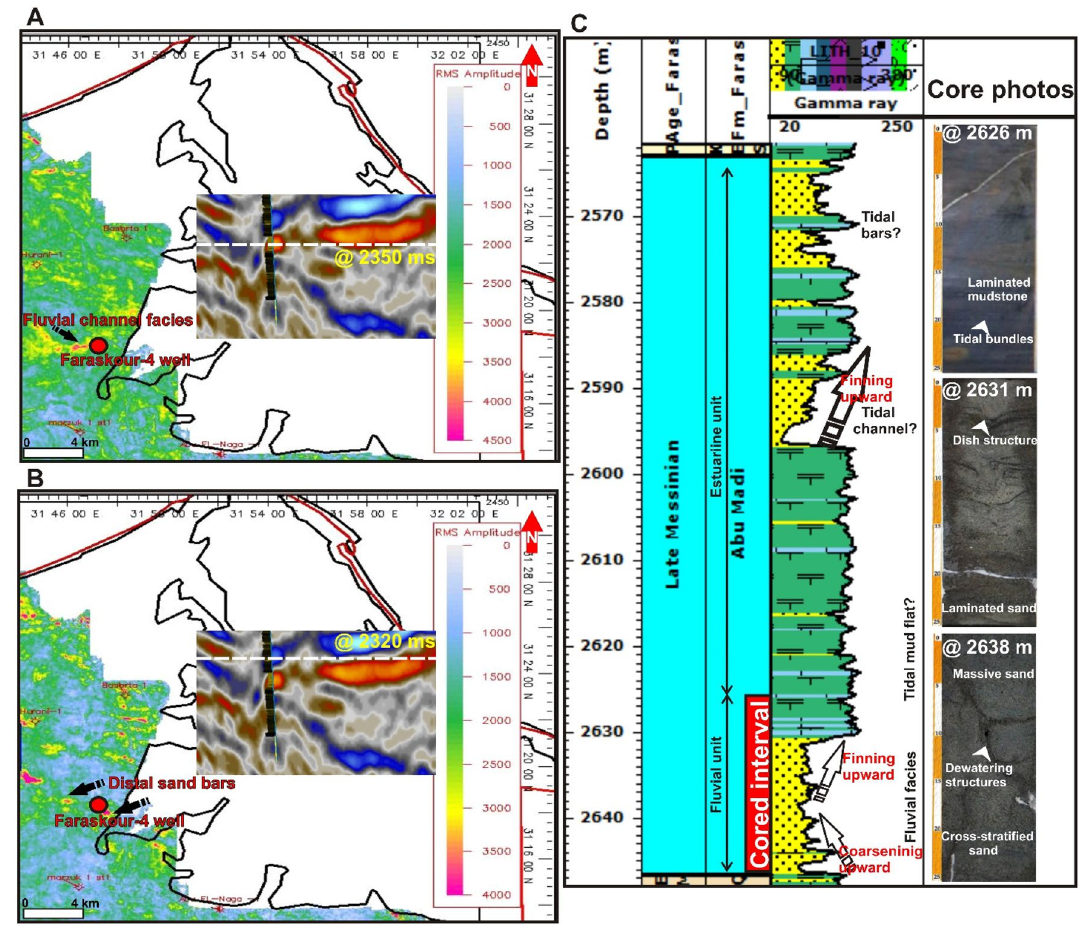
Fig. 7 Root-mean-square (RMS) amplitude maps of the Abu Madi upper reflectors. Extracted along the 2350 ms ( a ) and 2320 ms ( b ) reflections, and correlated with their corresponding core sedimentary facies ( c